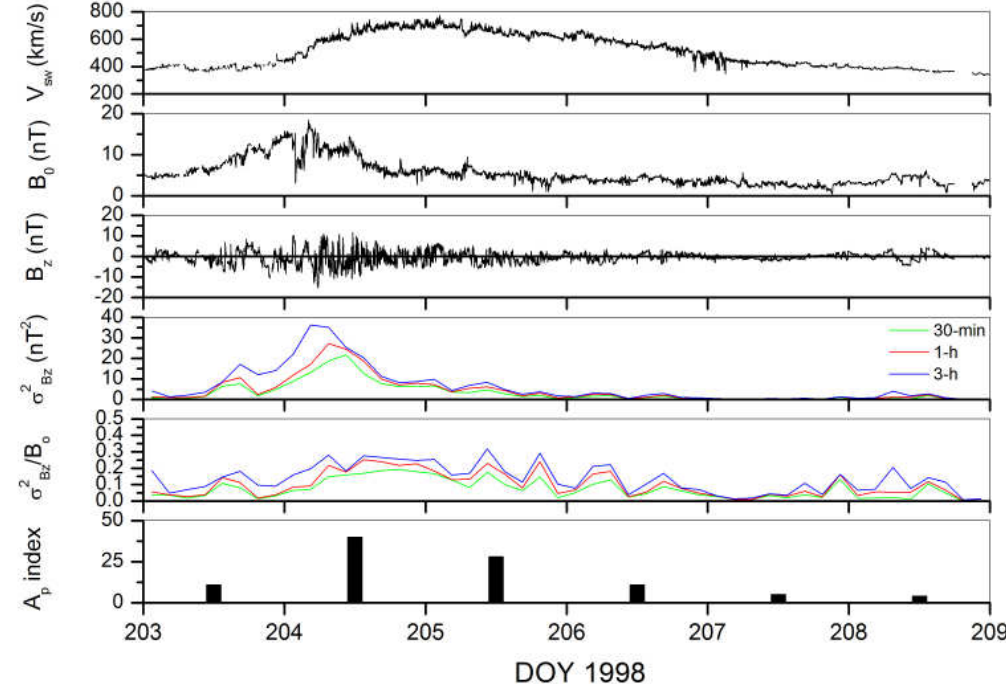
Fig. 8. A high speed stream during 1998 during the rising part of SC23. The format is the same as in Fig. 4, but the magnetic field magnitude B 0 has been added to illustrate the presence of the CIR and the effect it has on the B z variances and normalized B z